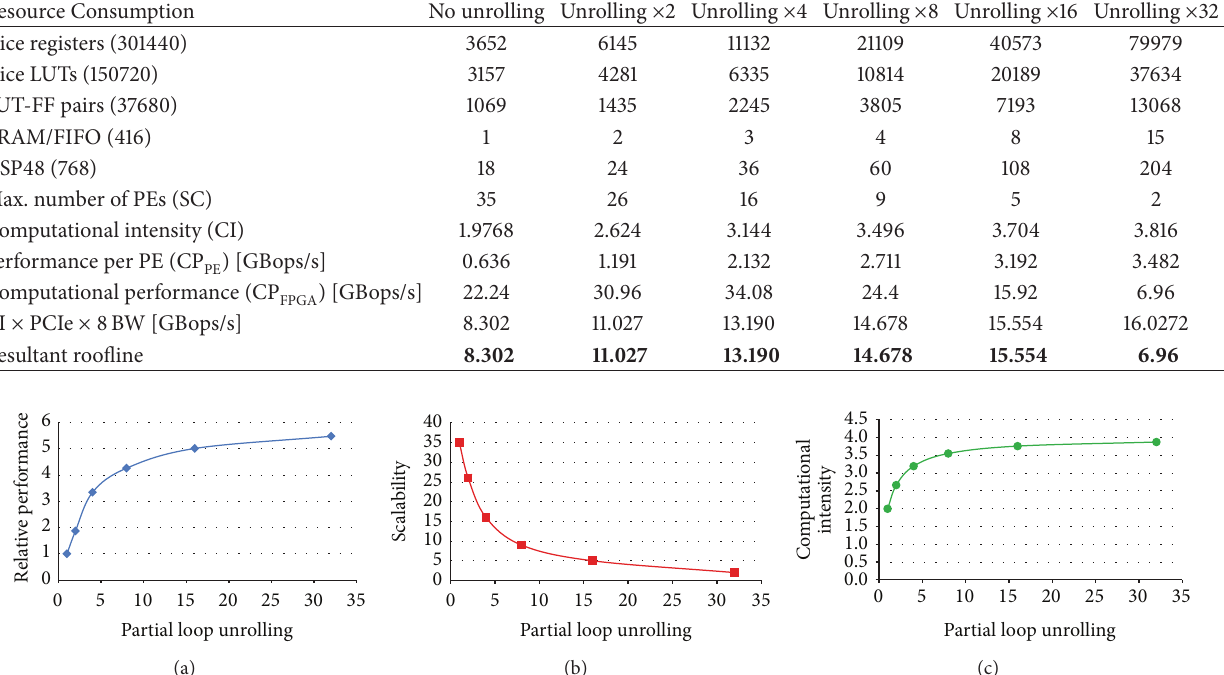
Table 1: Generation of the extended model for one FPGA based on the resource consumption, the computational performance of one PE, and the I/O limited performance obtained using ROCCC. The resultant roofline is obtained applying (2) and (4). Resource Consumption